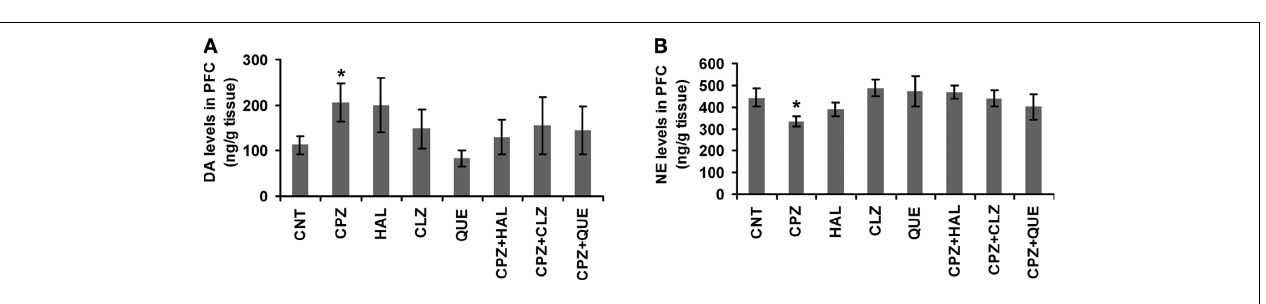
FIGURE 4 | Effects of antipsychotics on the CPZ-induced changes in levels of DA and NE in PFC. (A) Control and experimentally treated C57BL/6 mice were sacrifi ced on 14th day after CPZ-exposure. DA levels in PFC were measured by means of HPLC. (B) Control and experimentally treated